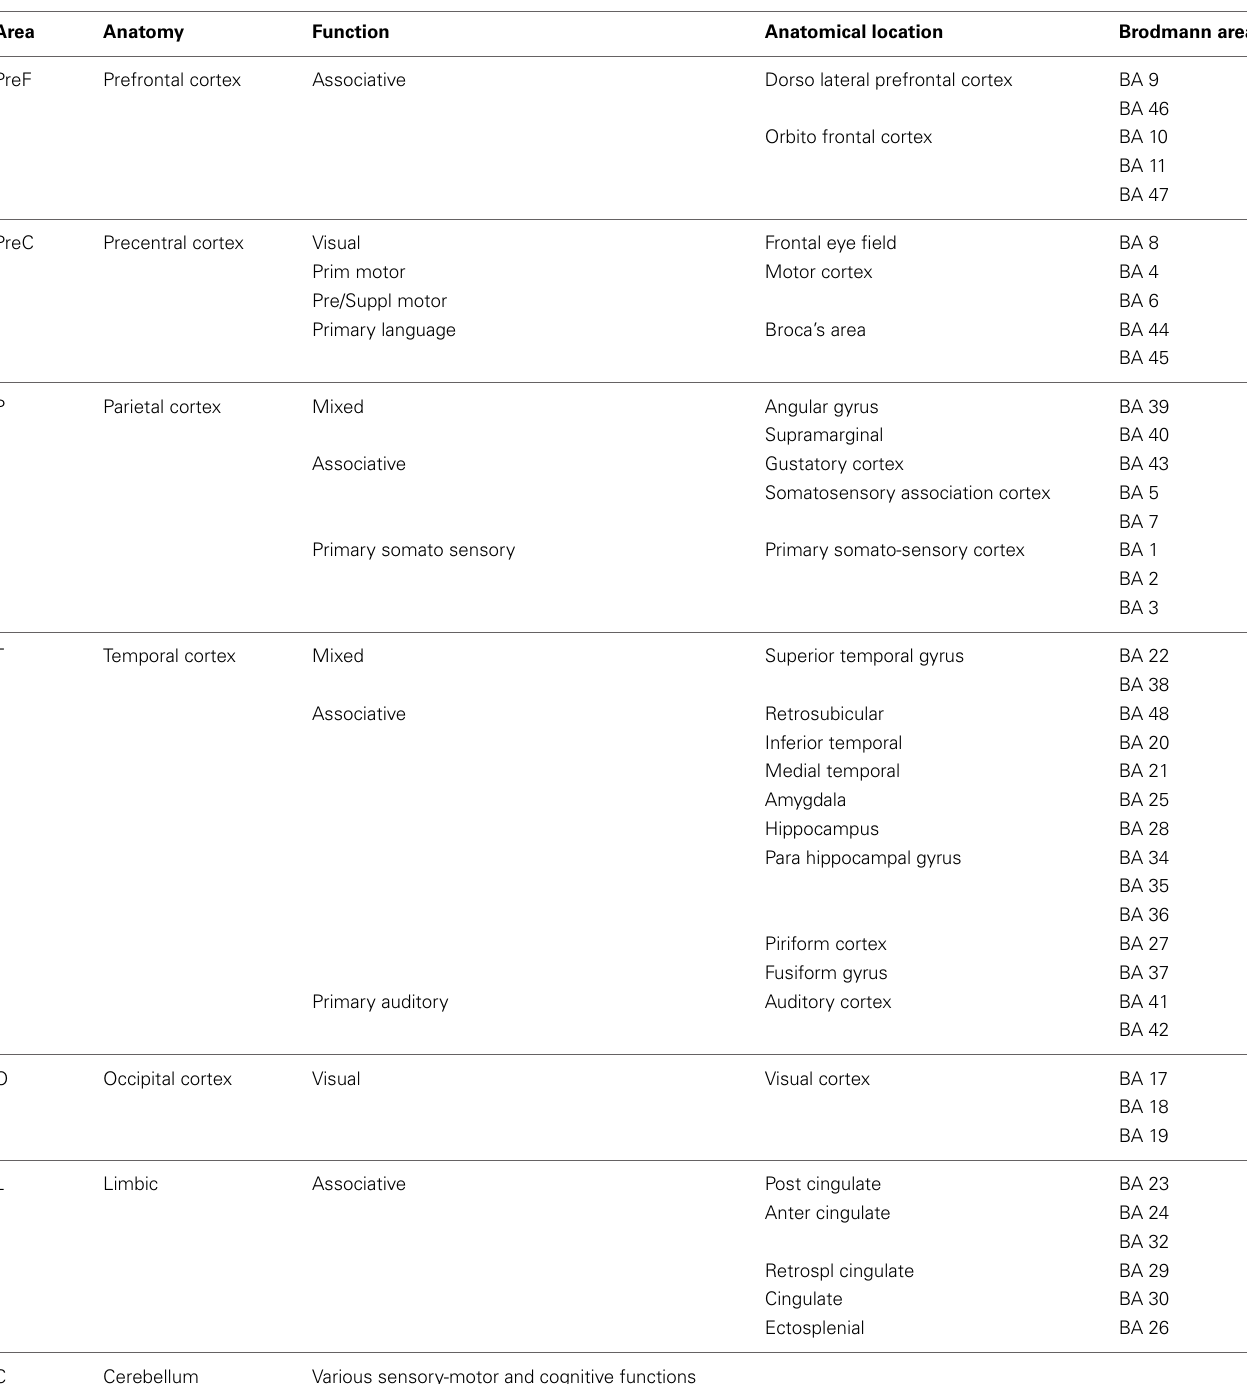
Table 1 | Brain subdivision used to assess the spatial distributions of RSN changes.